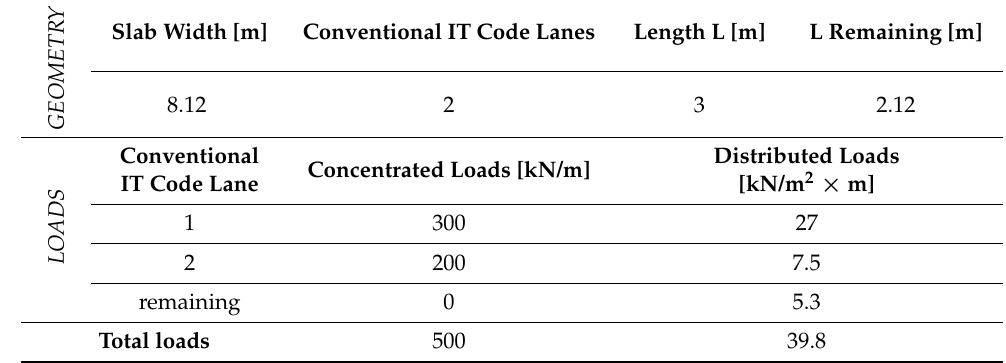
Table 1. Vertical load analysis of the viaduct. The table shows the conventional calculation of traffic loads that will be applied to the viaduct model in load scenario